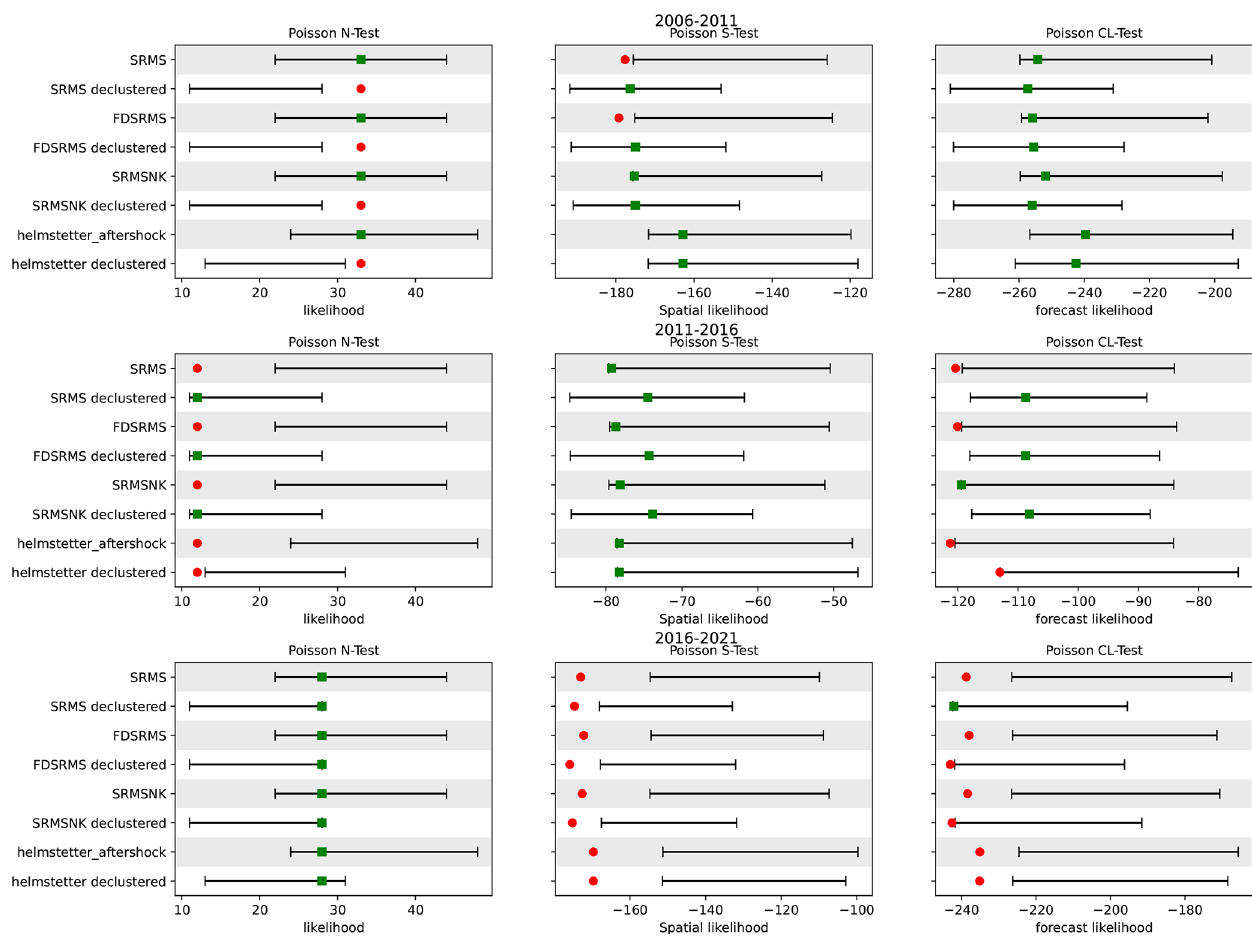
Figure 6. Grid-based forecast tests for all forecasts for three 5-year time periods: 2006–2011 (top), 2011–2016 (middle) and 2016– 2021(bottom). The bars represent the 95% confidence interval derived from simulated likelihoods from the forecast, while the symbol represents the observed likelihood for observed events. The green square identifies that a model has passed the test and a red circle indicates inconsistency between forecast and observation. The forecasts are compared to both the full (Helmstetter aftershock) and declustered models of Helmstetter et al. (2007). Models include combinations of smoothed past seismicity (MS), strain rate (SR), fault distance (FD) and fault slip rates